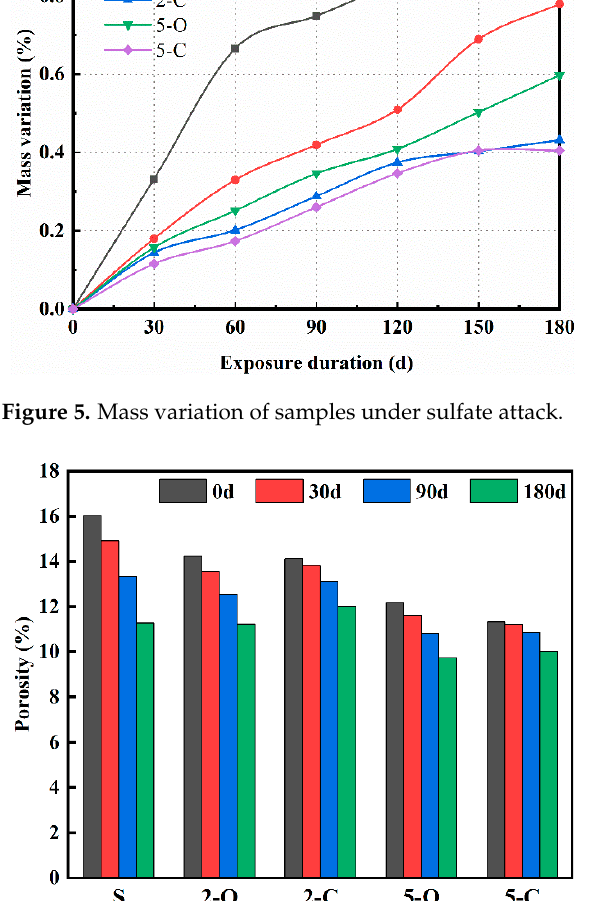
Figure 7. Compressive strength loss rates of samples under sulfate attack.